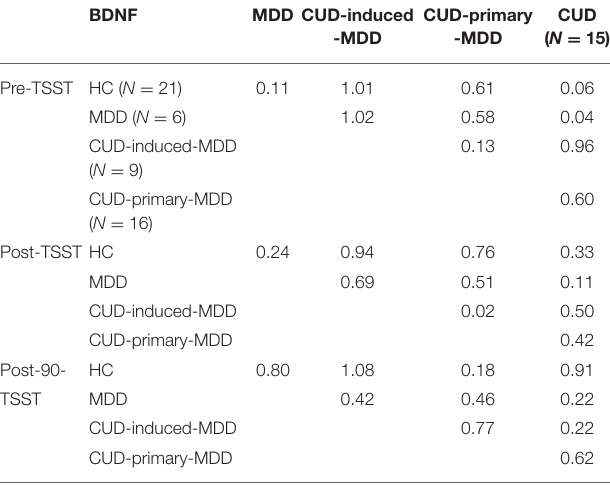
TABLE 5 | Effect size coefficient (Cohen’s d) pairwise comparisons of BDNF concentrations in each assessment. BDNF MDD CUD-induced